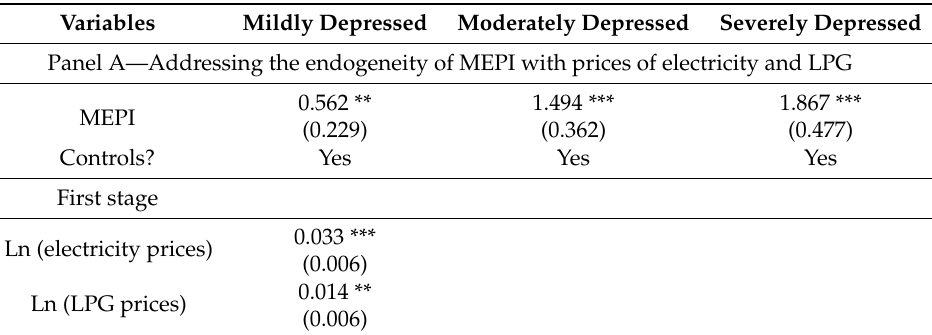
Table 5. Instrumental variable MLR-FE of the e ff ect of MEPI on depression.